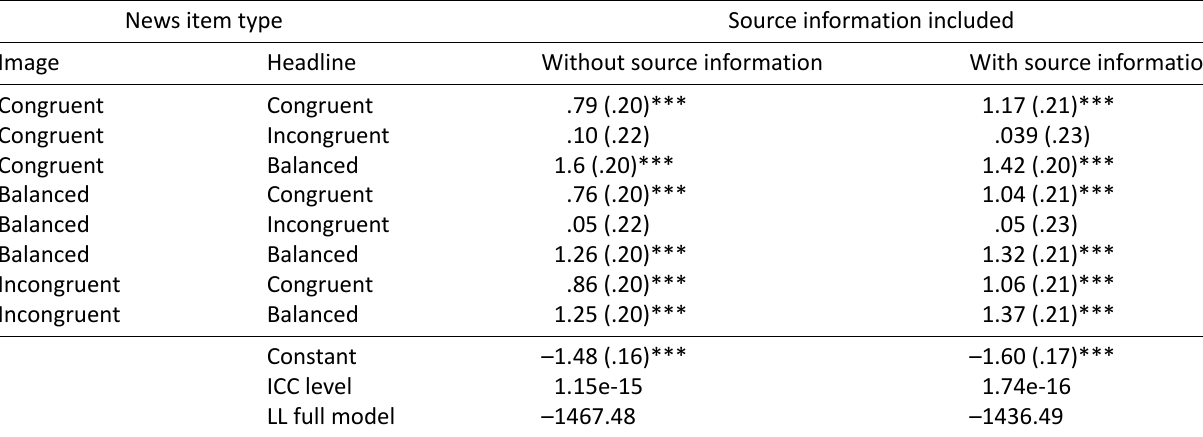
Table A4. Gun control context, logistic multilevel models explaining peoples’ selection of a news item, source and no